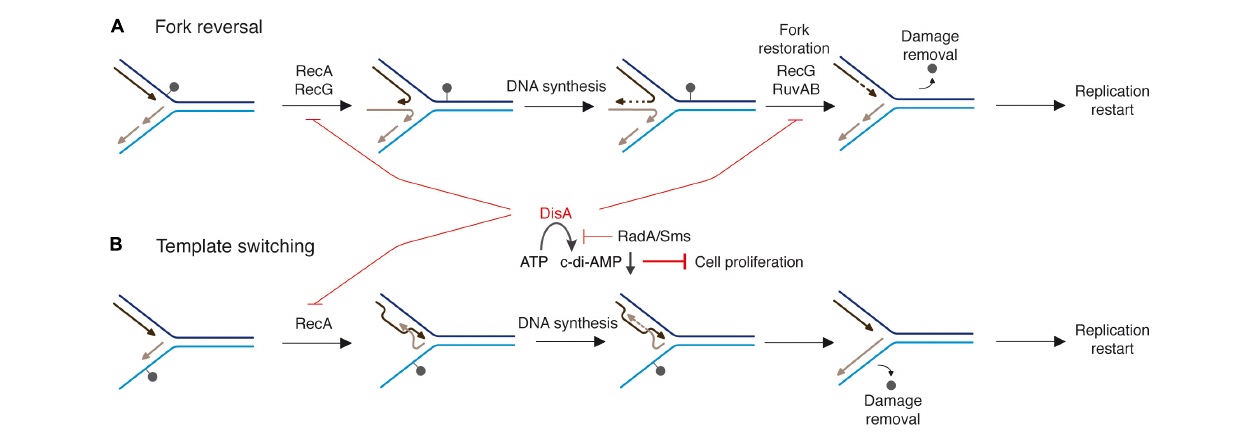
FIGURE 1 | Proposed mechanisms for RecA, DisA, RecG, RuvAB, and RadA/Sms in DNA damage tolerance pathways. When a replication fork encounters template DNA lesions, RecA assembles at the lesion-containing gap. RecA interacts with and loads DisA and RadA/Sms. Two error-free DDT pathways [fork reversal (A) and template switching (B) ] contribute to place the lesion on duplex DNA to permit repair and to generate the substrate for DNA synthesis to resume. (A) An unrepaired DNA lesion on the leading strand template (black dot) causes blockage of replication fork movement. A fork remodeler (e.g., RecG) reverses the fork by annealing the two nascent strands, with DisA limiting RecG activities. DNA synthesis of the DNA complementary to the damaged site (denoted by a dotted line) is followed by fork restoration catalyzed by RecG or RuvAB. Then, RadA/Sms with the help of RecA generates the substrate to be recognized by the pre-primosomal protein for replication re-start. (B) An unrepaired DNA lesion on the lagging strand template (black dot) causes blockage of replication fork movement. Finally, a substrate to be recognized by the pre-primosomal proteins for replication re-start should be